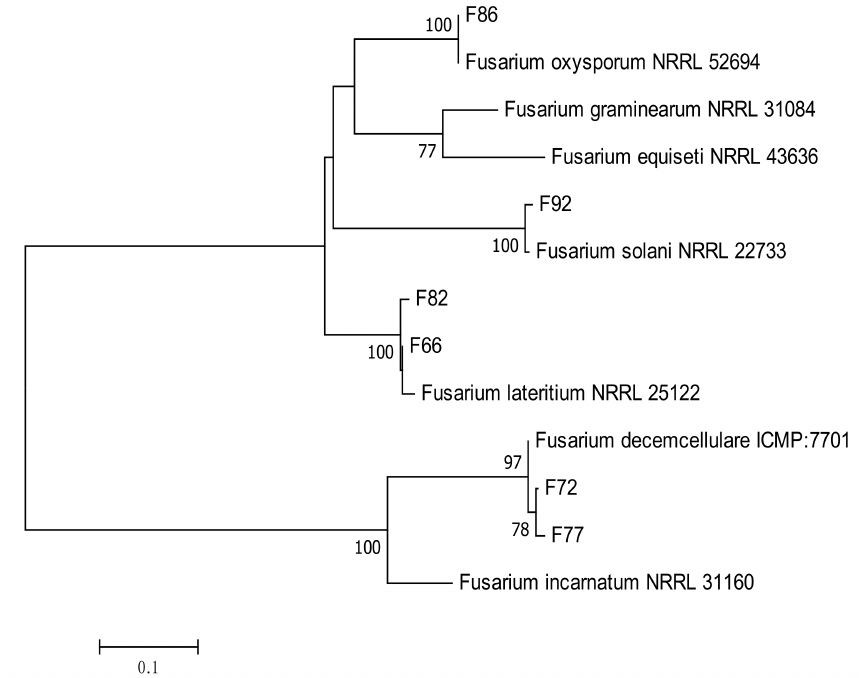
Figure 8. Maximum likelihood tree inferred from combined sequences of TEF-1 α and β -tubulin of Fusarium spp. from C. castaneus spines with bootstrap values higher than 50% are shown next to the branches.